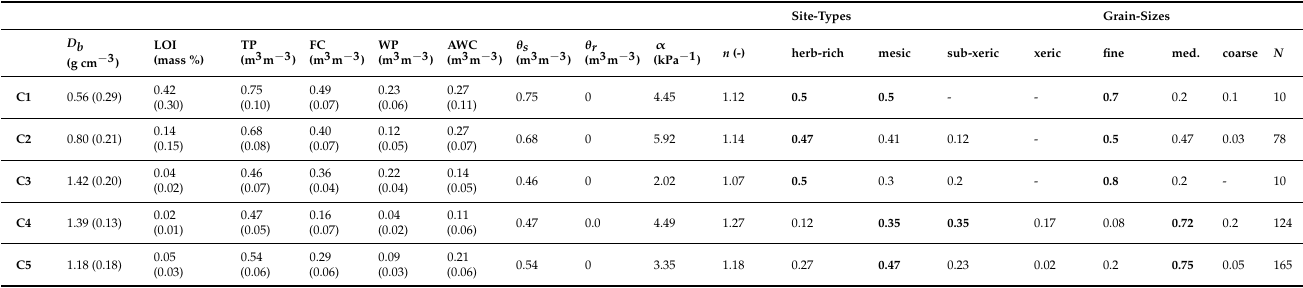
Figure 6. Decision tree for predicting WRC class (C1–C5) based on bulk density ( D b ), organic matter content (LOI) and clay fraction. The accuracy score of the decision tree is 0.84. Samples show the percentage of original samples that belong to certain leaves (boxes). The smaller the Gini impurity index and the larger the spread across the split vector elements (0…1), the more accurate each branch division is. The tree branches end to WRC classes. Table 1. Characteristics of the five clusters (C1–C5). Shown are the mean (std) of physi- cal/hydrological properties and cluster-mean MvG water-retention curve (Equation (1)) parameters. Relative proportion of site-types and NFI grain-size observations within each cluster is shown, and most frequent are shown in bold. N is the number of samples in each cluster. See Supplementary Figure S1 for MvG curves.